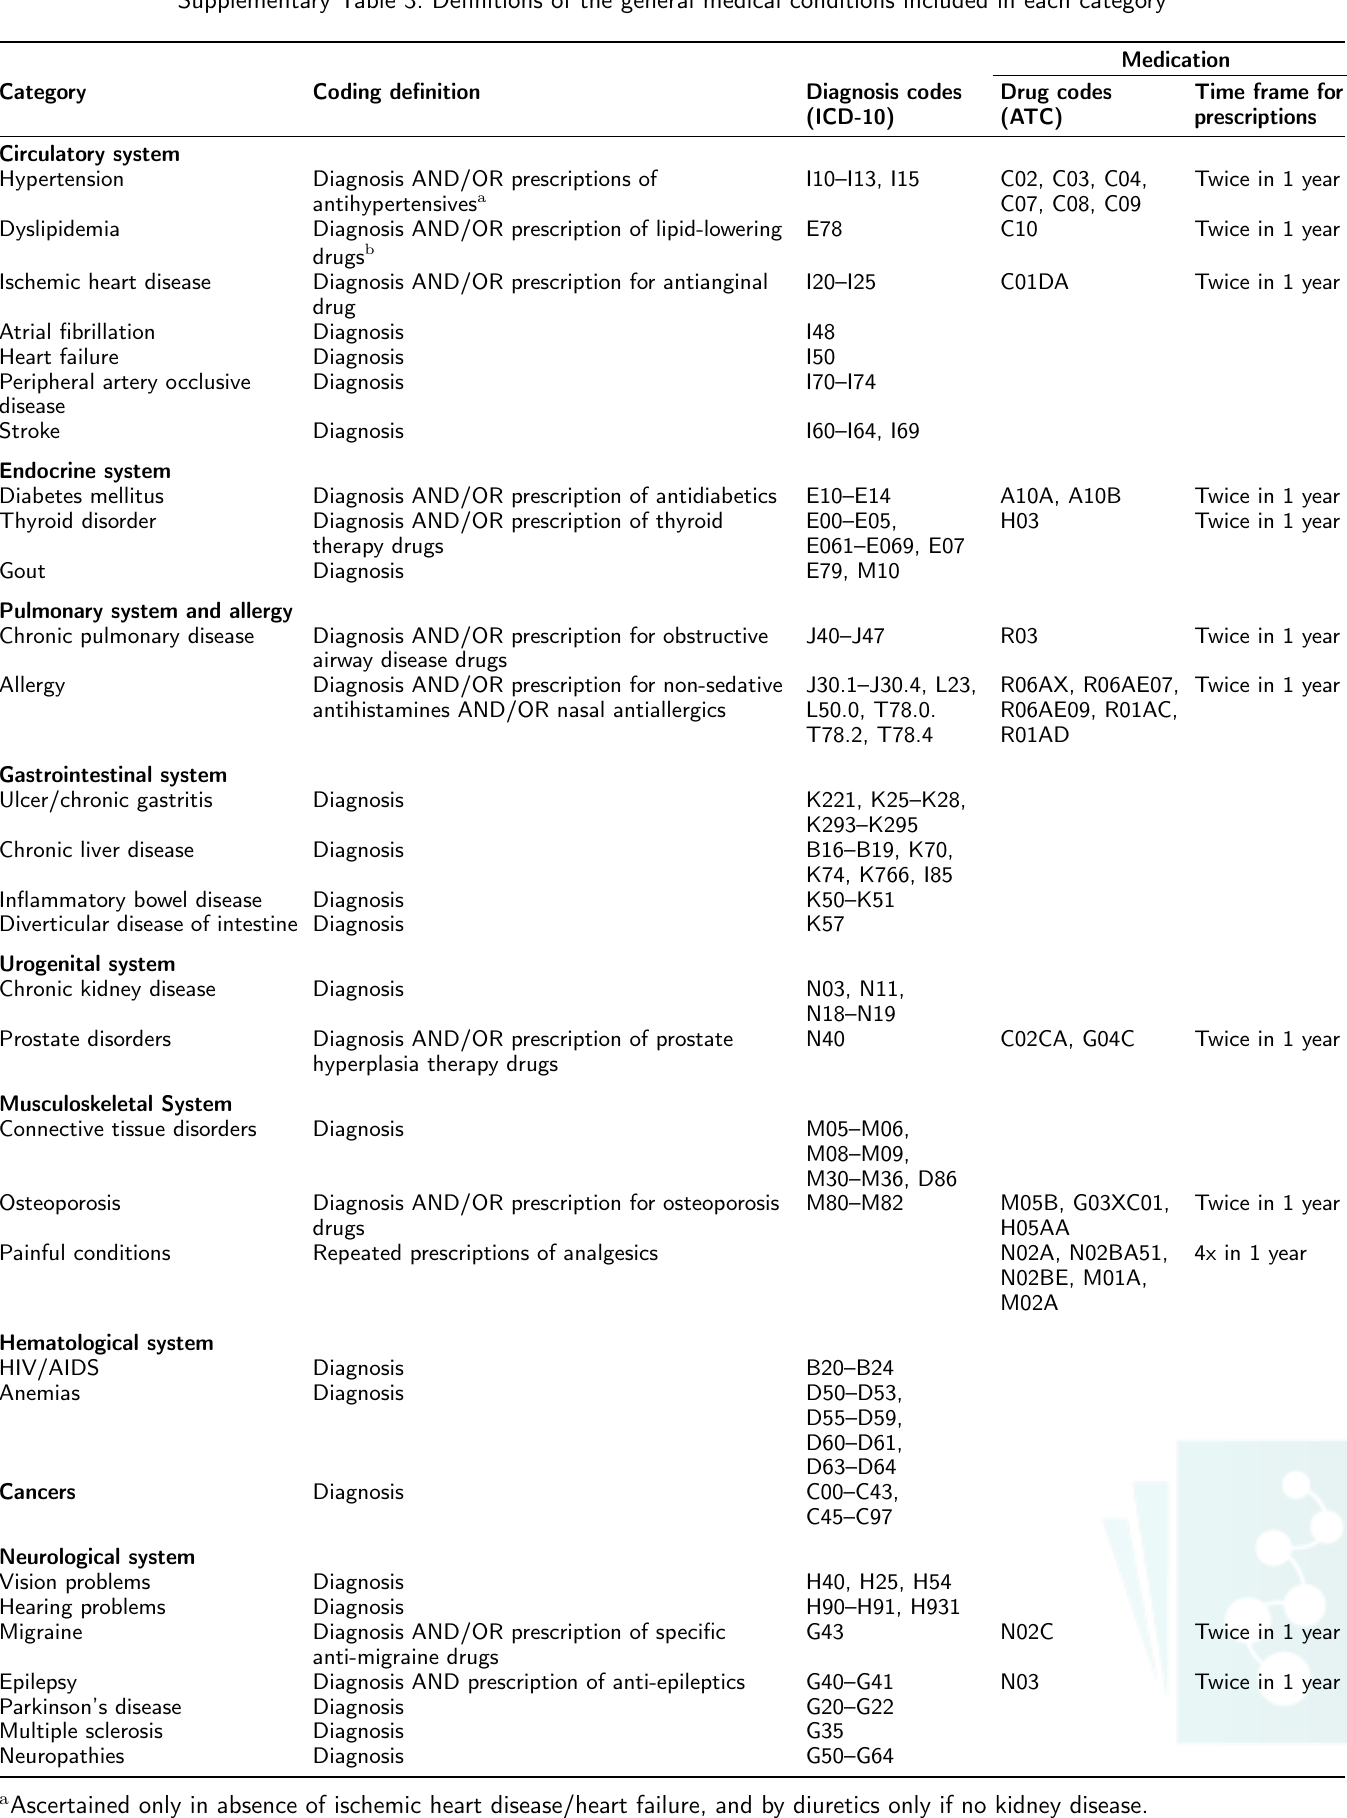
Supplementary Table 3: Definitions of the general medical conditions included in each